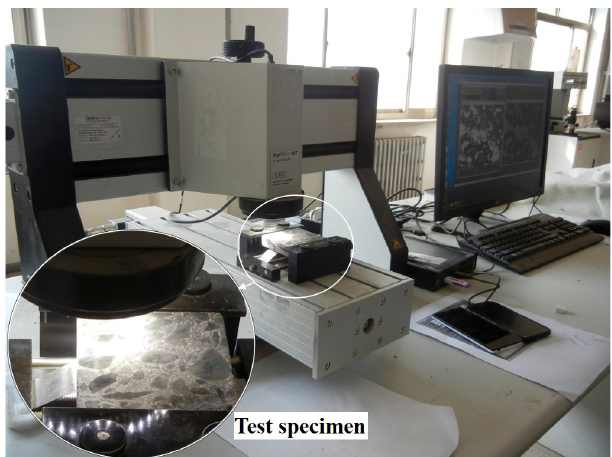
Figure 7. The RapidAir457 tester analyzing pore structure.